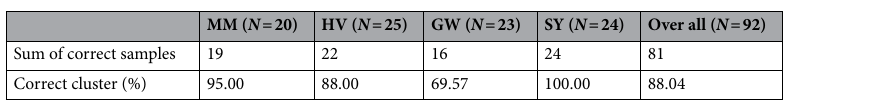
Table 6. Chamaecyparis formosensis individual provenance simulation result. A total of 92 samples composed of 20 MM, 25 HV, 23 GW, and 24 SY individuals were subjected to provenance simulation. Correct provenance is 95.00% (MM), 88.00% (HV), 69.57% (GW), and 100.00% (SY), with an overall mean correct rate of